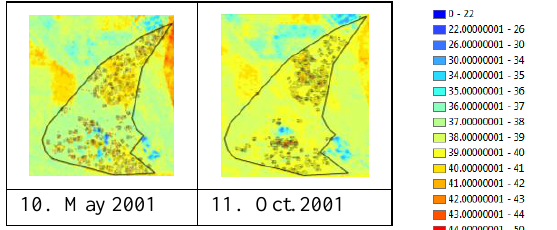
Figure 11. The multi-temporal Landsat and LST images for the Al-Jleeb Landfill